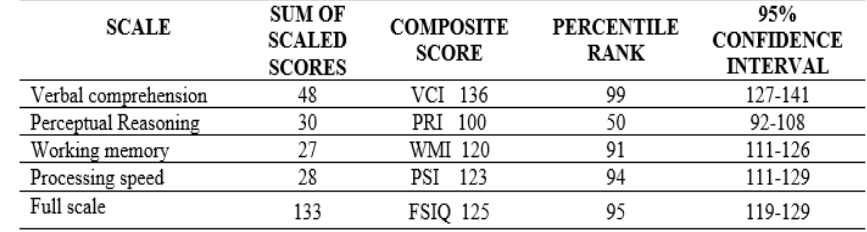
Table A - 2. Sum of scaled scores to composite score conversion